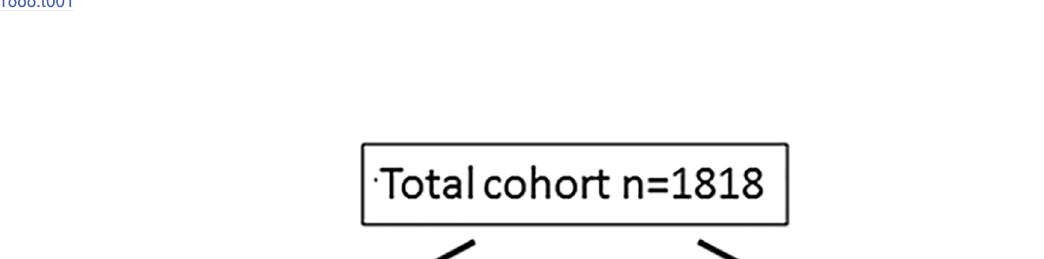
PLOS ONE | https://doi.org/10.1371/journal.pone.0221888 September 12,